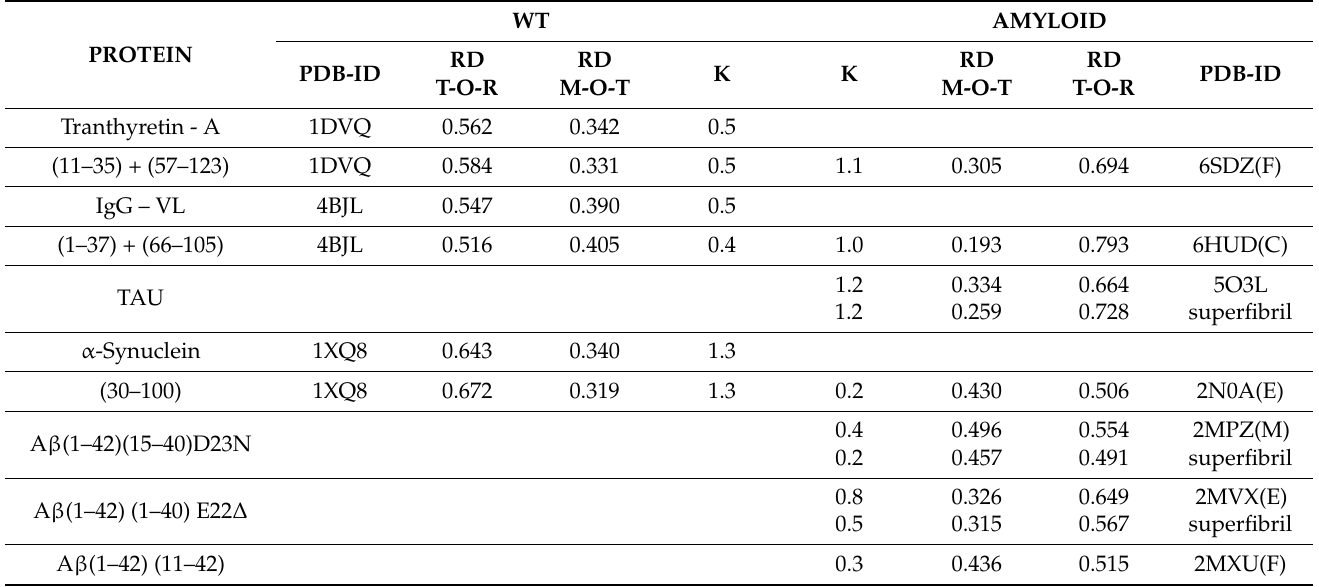
Table 2. List of proteins for which K values corresponding to the smallest distance ( D KL ) of the O distribution to the modified M distribution were determined. Parameter values were determined by regarding proto- and/or super-fibrils as units (a 3D Gaussian function was generated for proto-fibril and super-fibril).